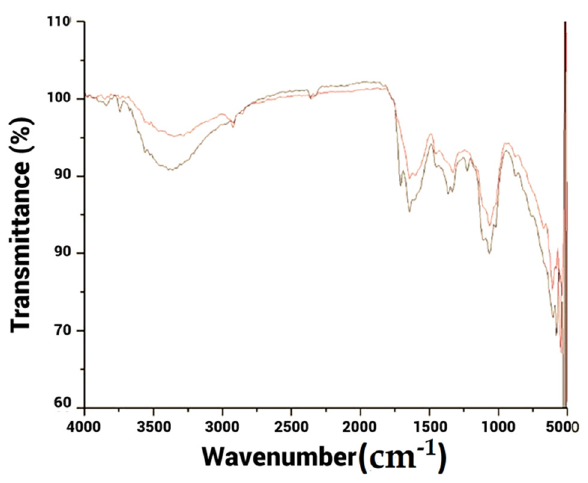
Figure 6. FTIR analysis of AC-AgNPs. Blackline: extract, redline: reaction mixture.